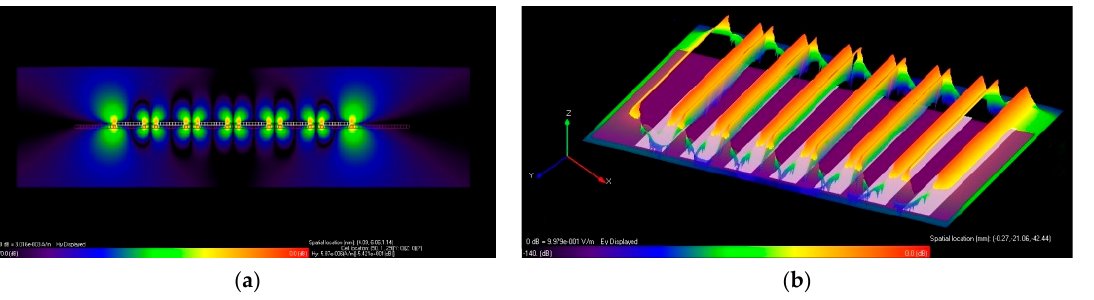
Figure 7. Numerical results for electric-field amplitude distribution near the strips; the field values are normalized to the amplitude of the incident field: ( a ) simulation with XFDTD where the Ey component and ( b ) dependency of the e.m.f. amplitude are induced in the reception coil of the sen- sor. Considering the middle of the slits as a reference point, symmetrically to left and right, a 1 mm distance was scanned, and along the length of the strip, a 1 mm distance was scanned; thus, a surface of 1 × 2 mm 2 is scanned, both on the sample without enzyme as well as the sample with enzymes. The EM field induced in the reception coil was meas- ured; the measurement system represents the average of 20 measurements for each point in order to reduce the white noise effect, with the bandwidth of the analyzer being set to 10 Hz to diminish the noise level. The acquisition through the IEEE 488 interface and stor- age of data are made by the same PC. Considering the middle of the slits as a reference point, symmetrically to left and right, a 10 mm distance was scanned, along the length of the strip distance, so that a surface of a 2 × 2 mm 2 structure was scanned in 10 μ m steps in both directions, both on the sample without as well as the sample with enzymes. Scanning along the y direction corresponds to a period of the grid in the frequency range 850 MHz– 900 MHz with a step of 1 MHz. Correlating the results obtained by measuring the ampli- tude of the EM field with the conditions obtained, it can be seen that the surface of the band becomes compact and dense and the distribution of the electric field along the band is approximately uniform (amplitude measured at each point represents the average of twenty different measurements) and evanescent waves can be observed. The spatial reso- lution of the system (distance between two distinctively visible points) was verified ac- cording to [42]. For gratings with features compatible with the value of the incident field, the TEz polarized wave acts at normal incidence for gratings [43]. Using the sensor